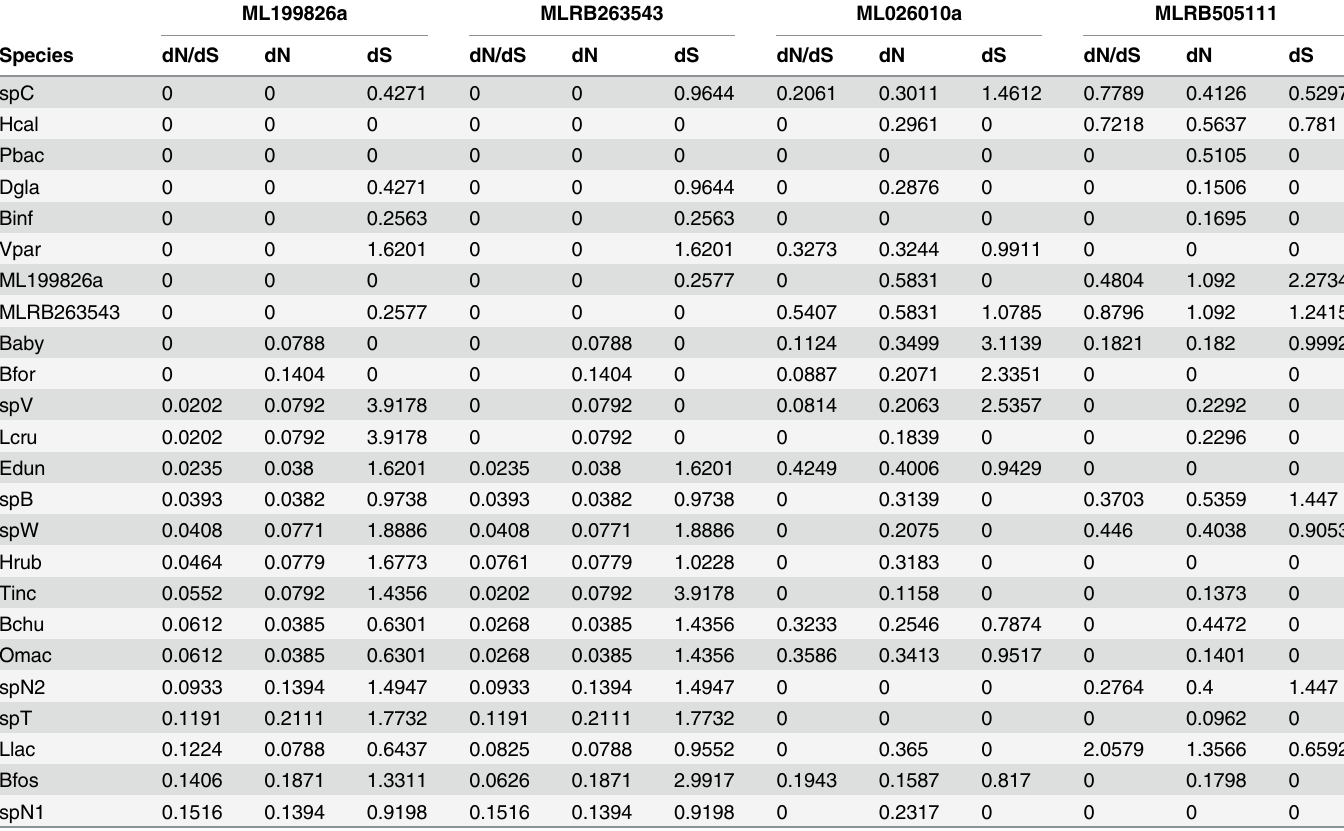
Table 8. Base substitution ratios for Mnemiopsis